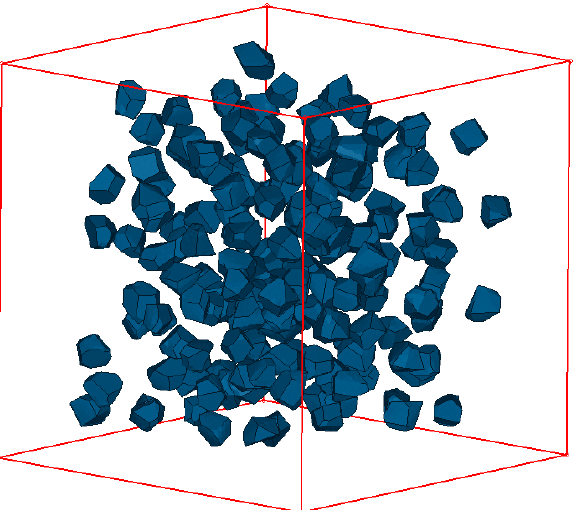
Figure 3. Separated aggregates in a certain space, which were generated using a shrinking process.